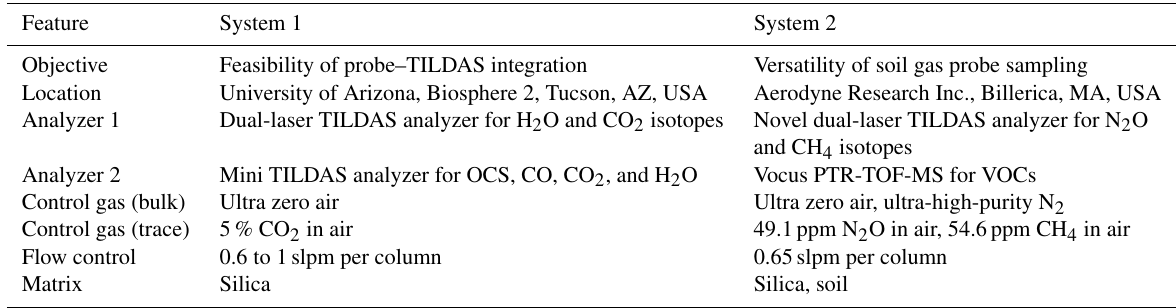
Table 2. Contrasting features between Systems 1 and